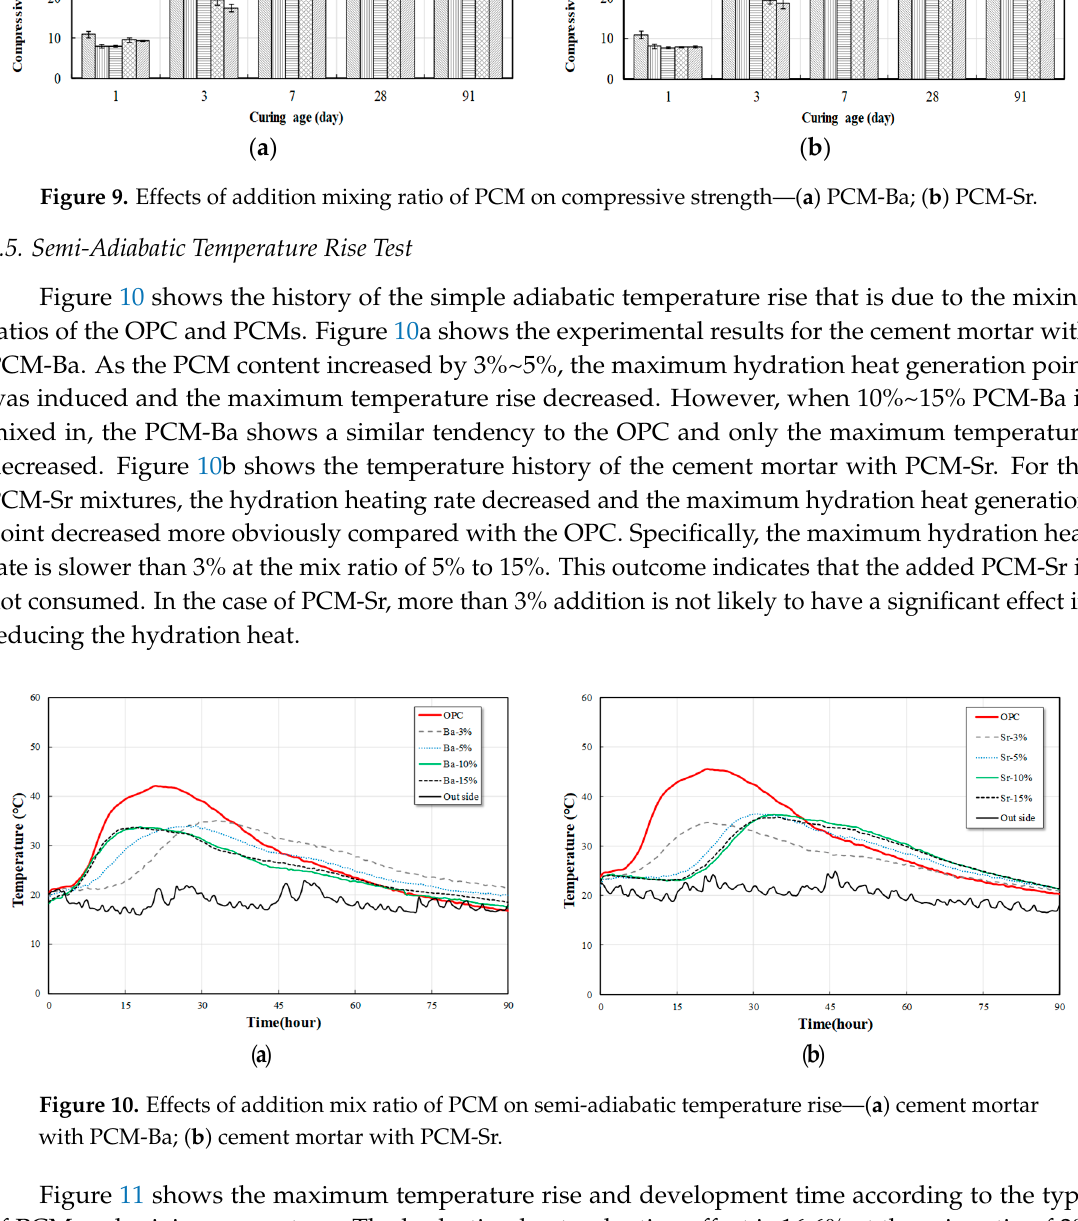
( b ) Figure 8. Effects of addition mix ratio of PCM on flexural strength—( a ) cement mortar with PCM-Ba; ( b ) cement mortar with PCM-Sr. Figure 9 shows the changes in compressive strength up to 91 days of aging according to PCM type and mix percentage. Overall, the compressive strength decreases with an increase in PCM content. As seen in Figure 5, PCM-Ba and PCM-Sr are dispersed in the hardened mortar matrix which disturbs the hydration of cement mortar. Moreover, the Mcdonaldite is not the hydration compound. Therefore, mechanical properties such as flexural strength and compressive strength were influenced negatively. At one day of aging, the compressive strength decreased for the specimens with 12.6% to 26.6% PCM-Ba and for specimens with 26% to 28.7% PCM-Sr. At three days of aging, the compressive